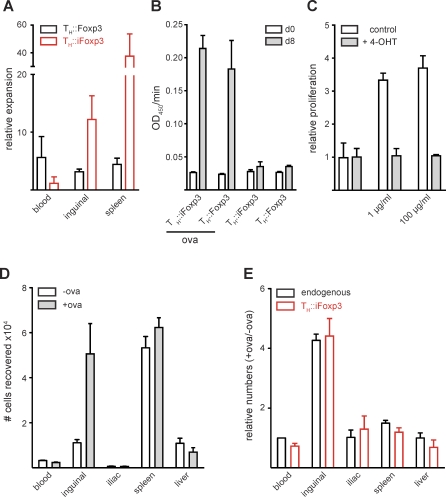
TH::iFoxp3 Cells Partake in the Immune Response and Suppress It upon Induction(A–C) Balb/c mice received 2 × 104 TH::Foxp3 or TH::iFoxp3 cells prepared from DO11.10xSCID mice before being immunized s.c. with either ova in CFA (+ova) or CFA alone (−ova) (n = 3 in each case).(A) The frequency of GFP+ cells was measured eight days after immunization and the relative expansion was calculated as %GFP+ (+ova) / %GFP+ (-ova).(B) Total ova-specific antibodies in prebleeds (d0, white bars; n = 2 in each case) and 8 d after immunization (d8, grey bars; n = 3 in each case) in immunized and naive mice.(C) Total splenocytes were isolated from mice that had received TH::iFoxp3 cells and were challenged with the indicated amounts of ova for 72 h in the absence (white bars) or presence (grey bars) of 50 nM 4-OHT. The total proliferation was measured by 3H-thymidine incorporation, and the relative proliferation was calculated as (+ova / (−ova).(D and E) Mice received 1 × 106 polyclonal TH::iFoxp3 cells and were immunized s.c. with ova in CFA. A week later, various tissues were analyzed.(D) The total number of recovered TH::iFoxp3 cells from immunized mice (red, n = 3) or nonimmunized mice (black, n = 3) was calculated.(E) The relative number of endogenous and TH::iFoxp3 cells was calculated as a ratio between immunized and nonimmunized mice. All error bars represent SEM, and p-values were determined using an unpaired t-test.